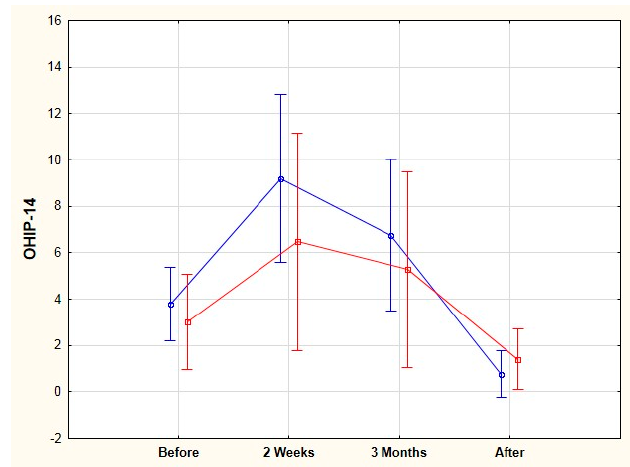
Figure 2. The 14-item Oral Health Impact Profile (OHIP-14) mean total score values before, during, and after orthodontic treatment in cancer survivors’ (blue line) and control (red line) groups.